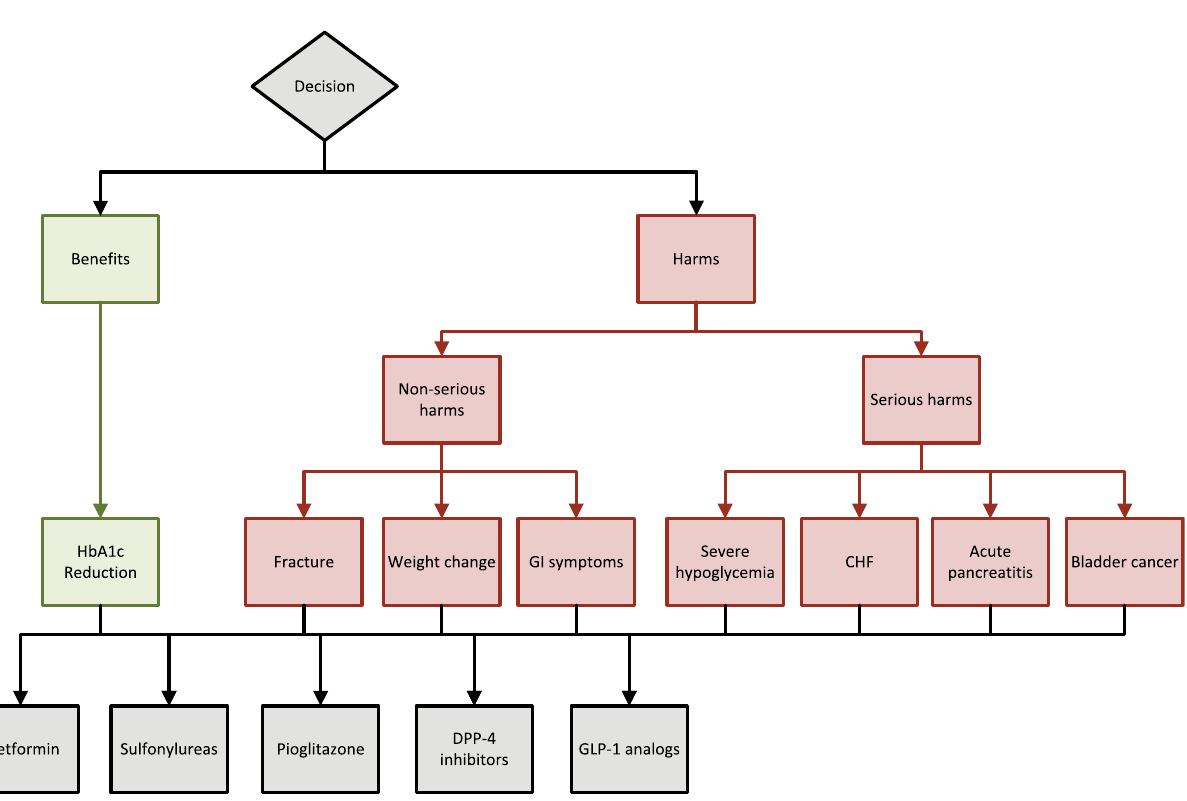
Figure 1. Final Analytical Hierarchy Process Model. The first step in Analytic Hierarchy Process analysis consists of defining the goal of the decision, the alternatives being considered, and the criteria to determine how well the alternatives can be expected to meet the goal. As seen above, these are organized into a hierarchical decision model with the goal at the top, alternatives at the bottom, and criteria in